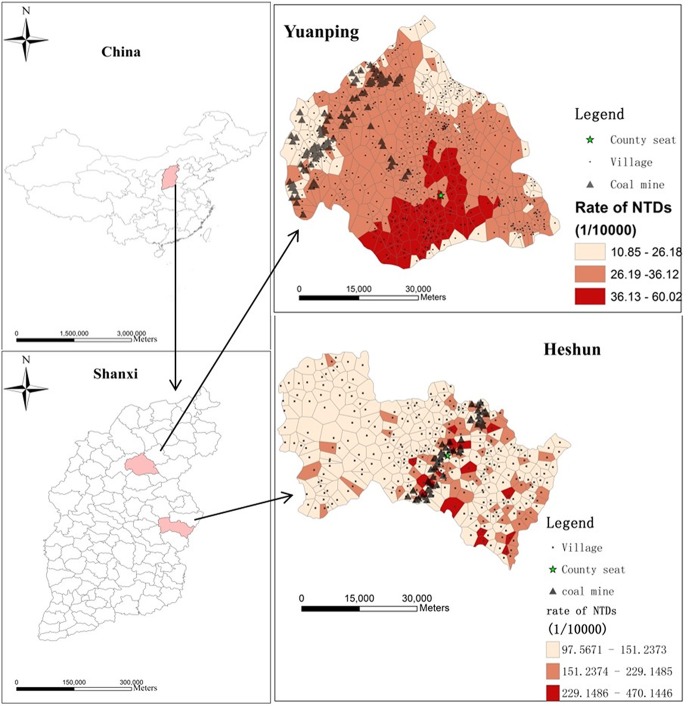
Location of study areas.